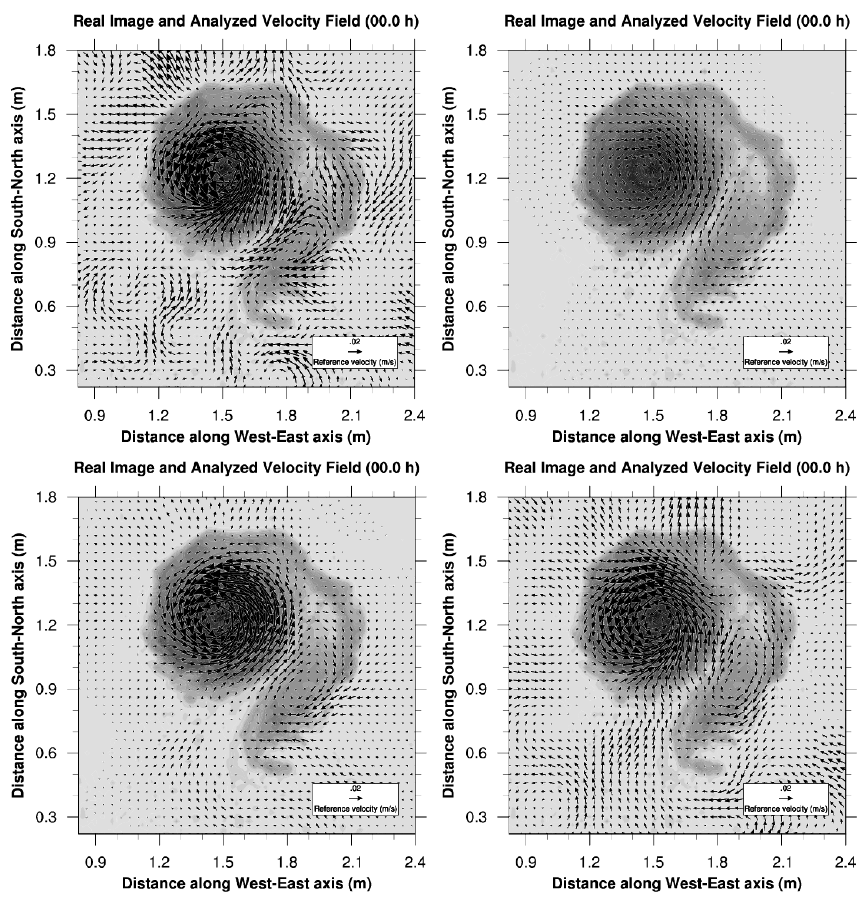
Figure 8. Analyzed initial velocity field computed by direct image sequence assimilation with different image observation operators: iden- tity operator (top left panel); curvelet decomposition and hard thresholding (top right panel); curvelet decomposition and scale-by-scale thresholding (bottom left panel); curvelet decomposition and hard thresholding zeroing coarsest scale (bottom right panel).